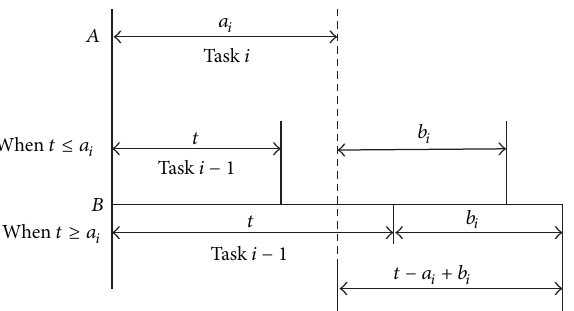
Figure 1: Diagram of standard scheduling personnel problem.